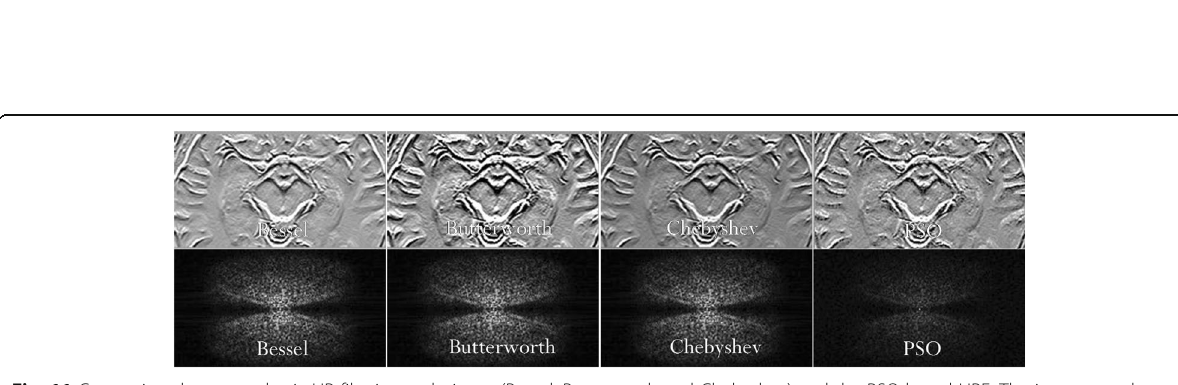
Fig. 11 Comparison between classic HP filtering techniques (Bessel, Butterworth and Chebyshev) and the PSO-based HPF. The images on the bottom row are the k-space magnitude images of the signals located in the top